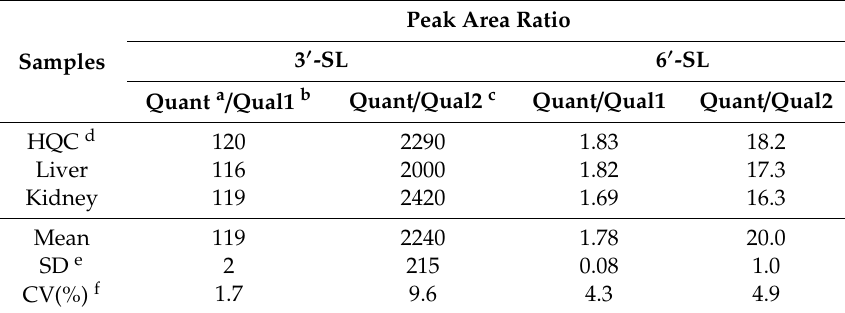
Table 1. Assessment of selectivity for 3 ′ -SL and 6 ′ -SL.